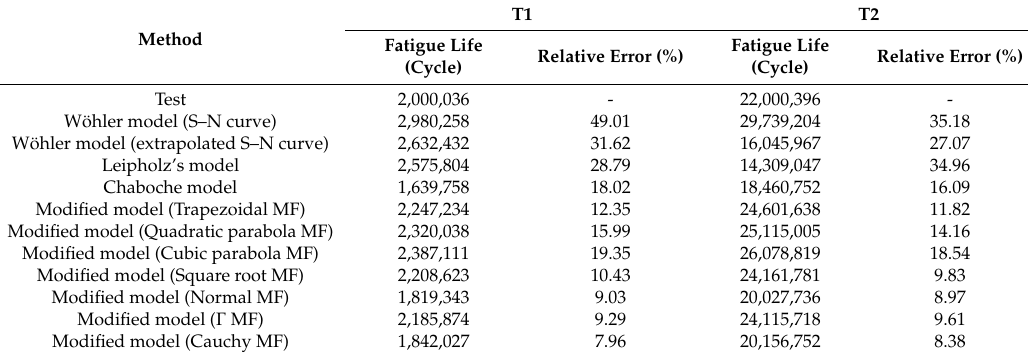
Table 2. Comparisons between different fatigue models and test.